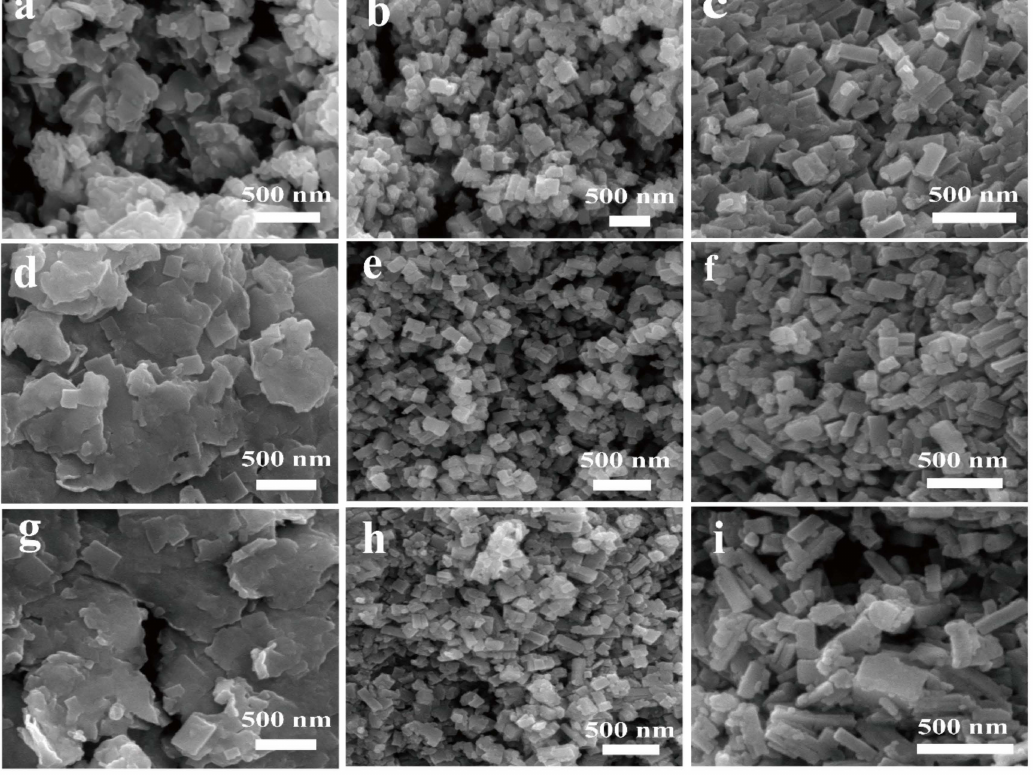
Figure 2. SEM images of the samples. Nanoplates, solution B: 18.4 mg PbI 2 , 12.8 mg MAI, 20 mL acetonitrile, dropping rate: 1 mL / min, dried at ( a ) 50 ◦ C (Np-50), ( d) 70 ◦ C (Np-70), and ( g ) 95 ◦ C (Np-95). Nanocubes, solution B: 18.4 mg PbI 2 , 18.4 mg MAI, 20 mL acetonitrile, dropping rate: 26 mL /